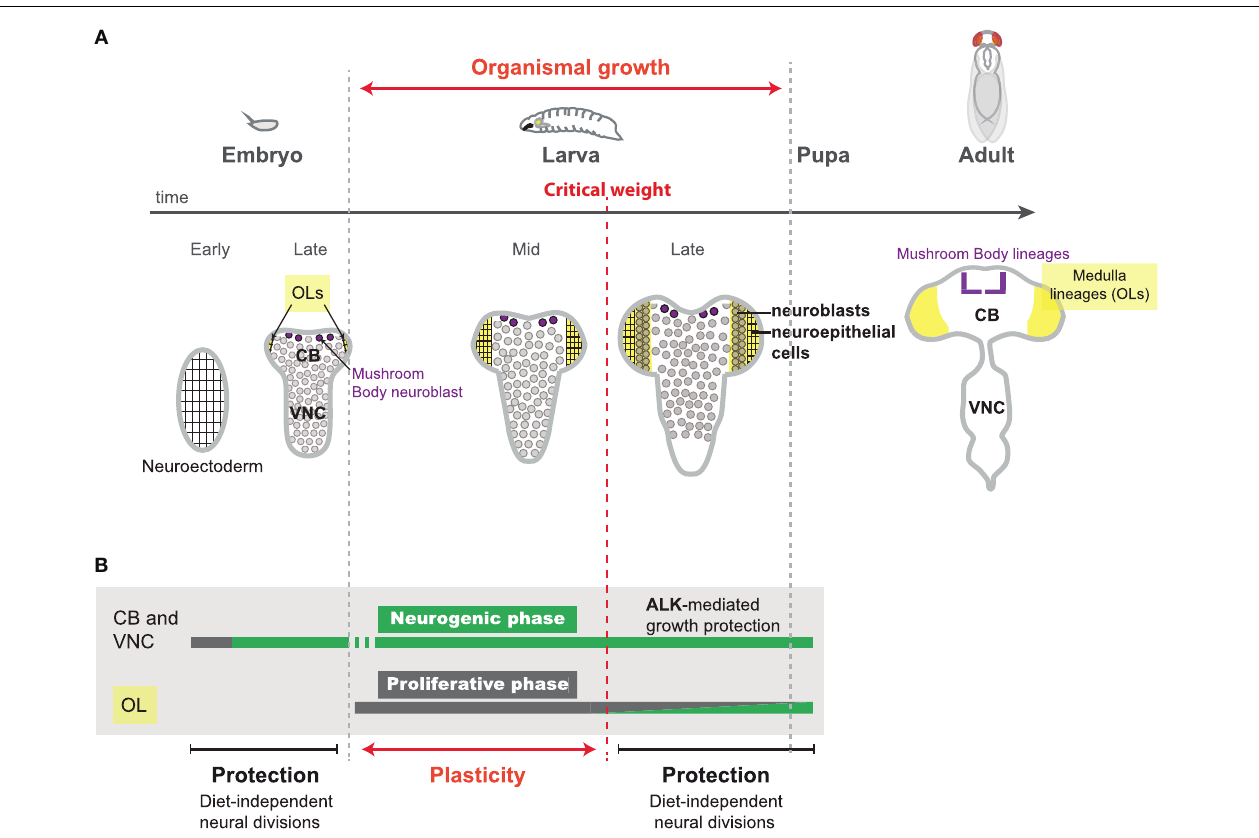
cells) starts expanding (proliferative phase) as the larvae starts feeding. When the larva reaches the “critical weight,” pulses of ecdysone are produced that promote the conversion of the neuroepithelium in neuroblasts (circular cells), which generate neurons (neurogenic phase). (B) During embryonic stages, neural divisions are not influenced by dietary conditions, as embryos are isolated from the environment and possess their own nutritional reserves. Sparing of neural growth and division also occurs after reaching critical weight when the animal possesses large amounts of endogenous nutritional reserves to fuel biogenesis. In the CB and VNC, neuroblast growth is additionally supported by insulin-independent growth Alk activity